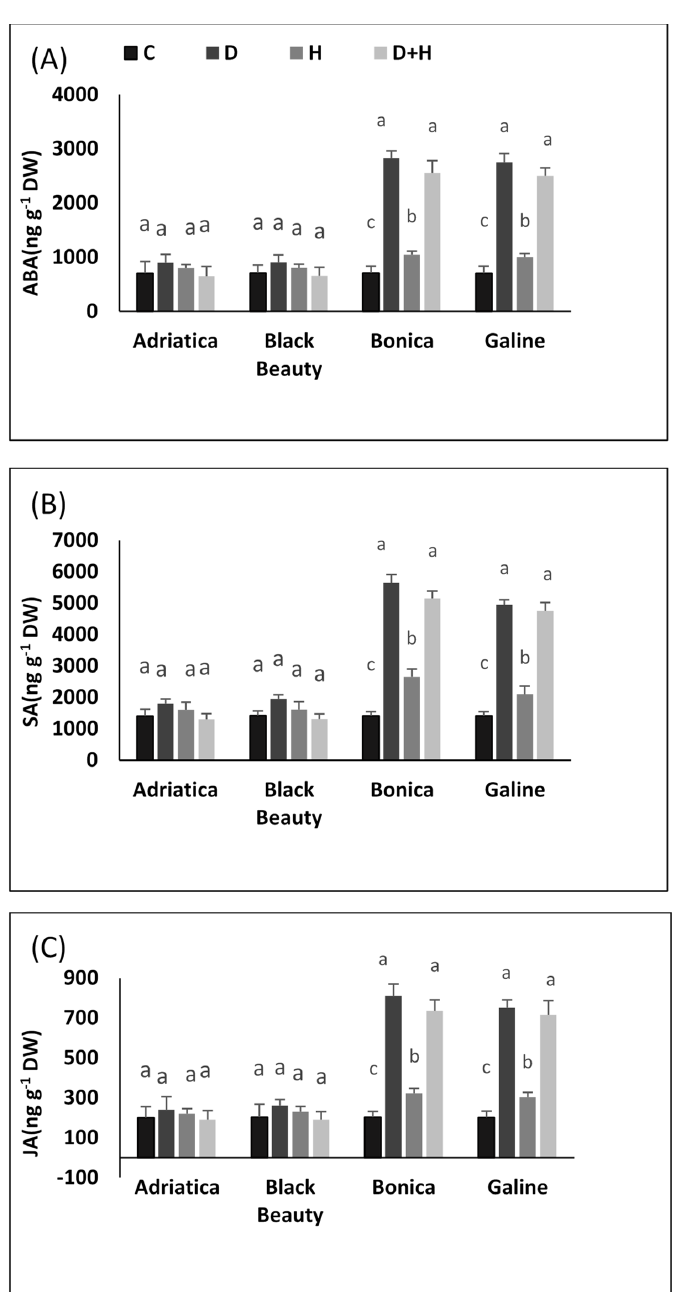
Figure 7. Changes in ( A ): abscisic acid (ABA), ( B ) salicylic acid (SA), and (JA) jasmonic acid ( C ) of four eggplant cultivars under individual and associated stresses. Data presented are the means ± SE ( n = 5). Significant dissimilarities are shown by different lower-case letters between treatments ( p ≤ 0.05) based on Tukey’s test. (C, control; H, heat stress; D, drought stress; H + D, heat + drought stresses).